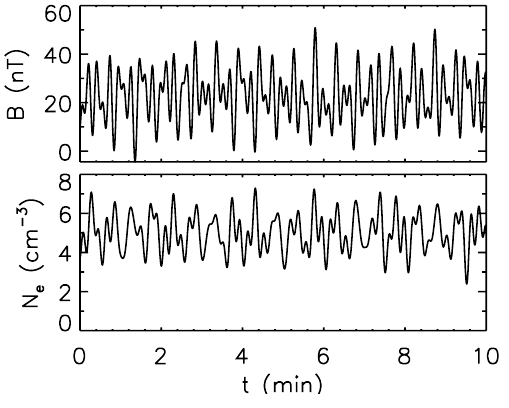
Fig. 1. Time series of artificial magnetic field and density fluctua- tion at the virtual sensor 1.